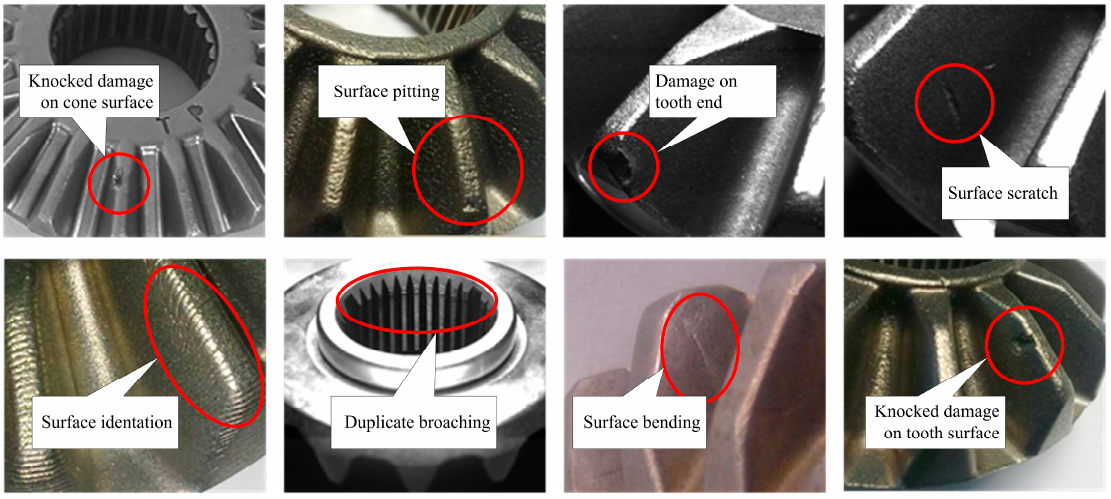
Figure 3. Examples of defects on bevel gear surface.